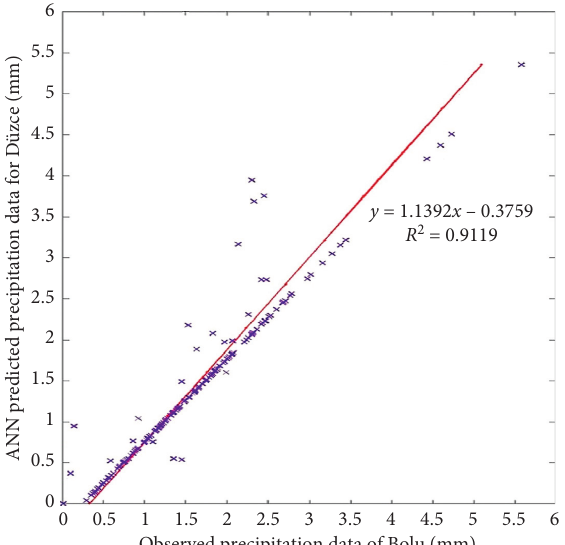
Figure 4: Observed Bolu and predicted D¨uzce monthly rainfall (January 1995 to November